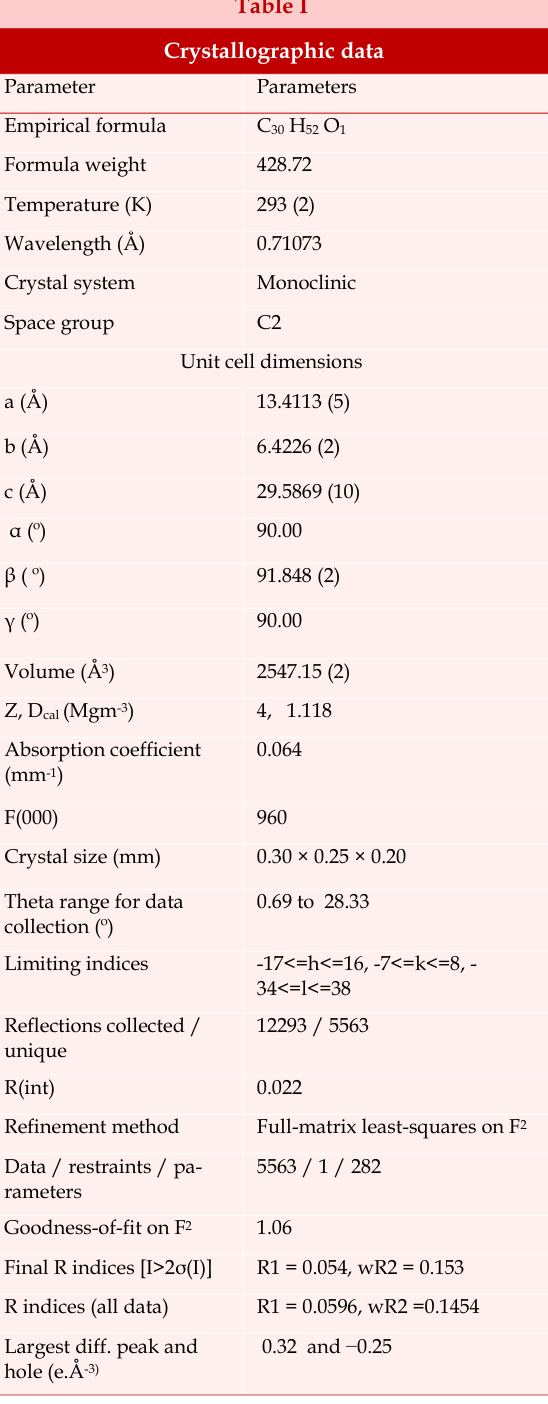
Crystallographic